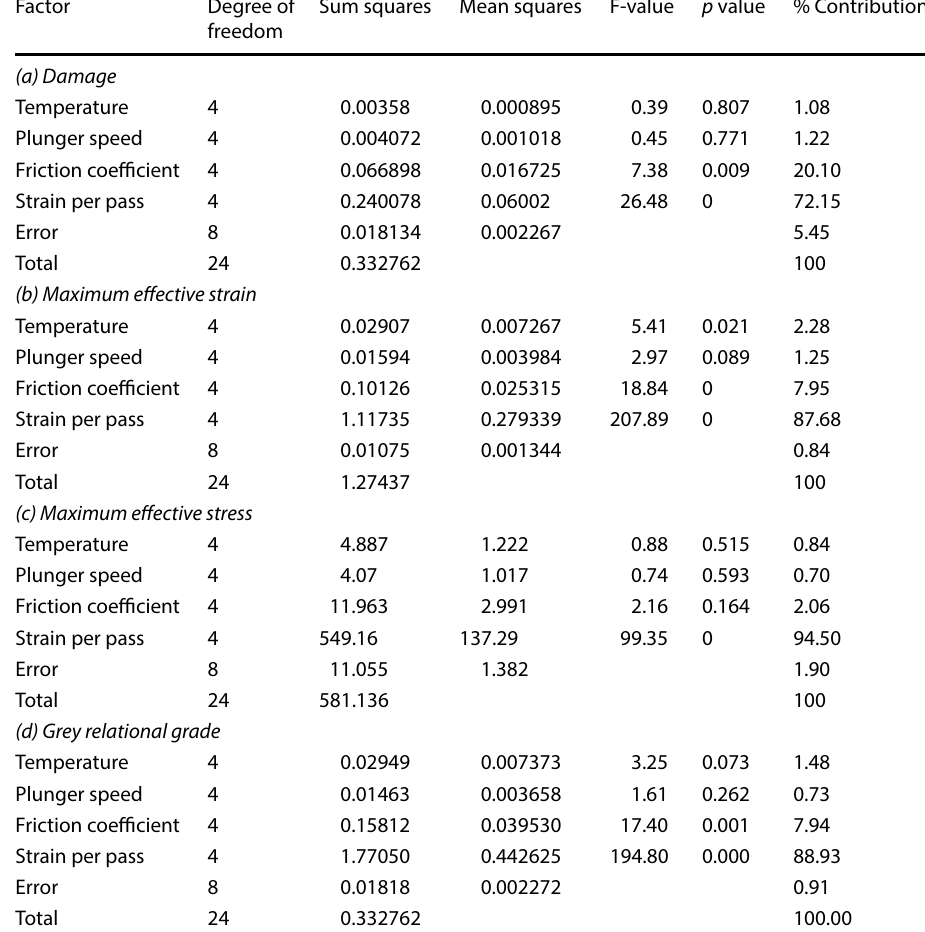
Table 8 Analysis of variance for transformed grade response